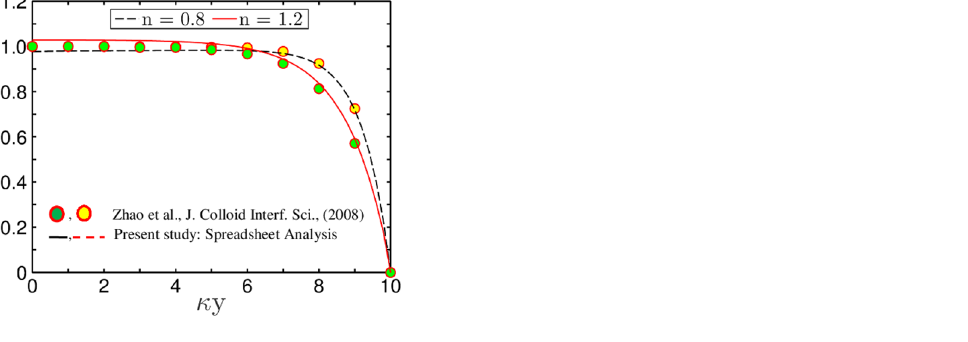
Figure 5. Plots depict validation of the present CFD code with that of Zhao et al. 28 using Spreadsheet analysis tool. The solid lines depicts the velocity half profile obtained from the present study, while, the markers represent the analytical solution obtained by Zhao et al. 28 . The parameters used for validation are κ = 10 , and Ŵ = 0 for n = 0.8 and n = 1.2 . The velocity profile is obtained at z = 0 for both cases.